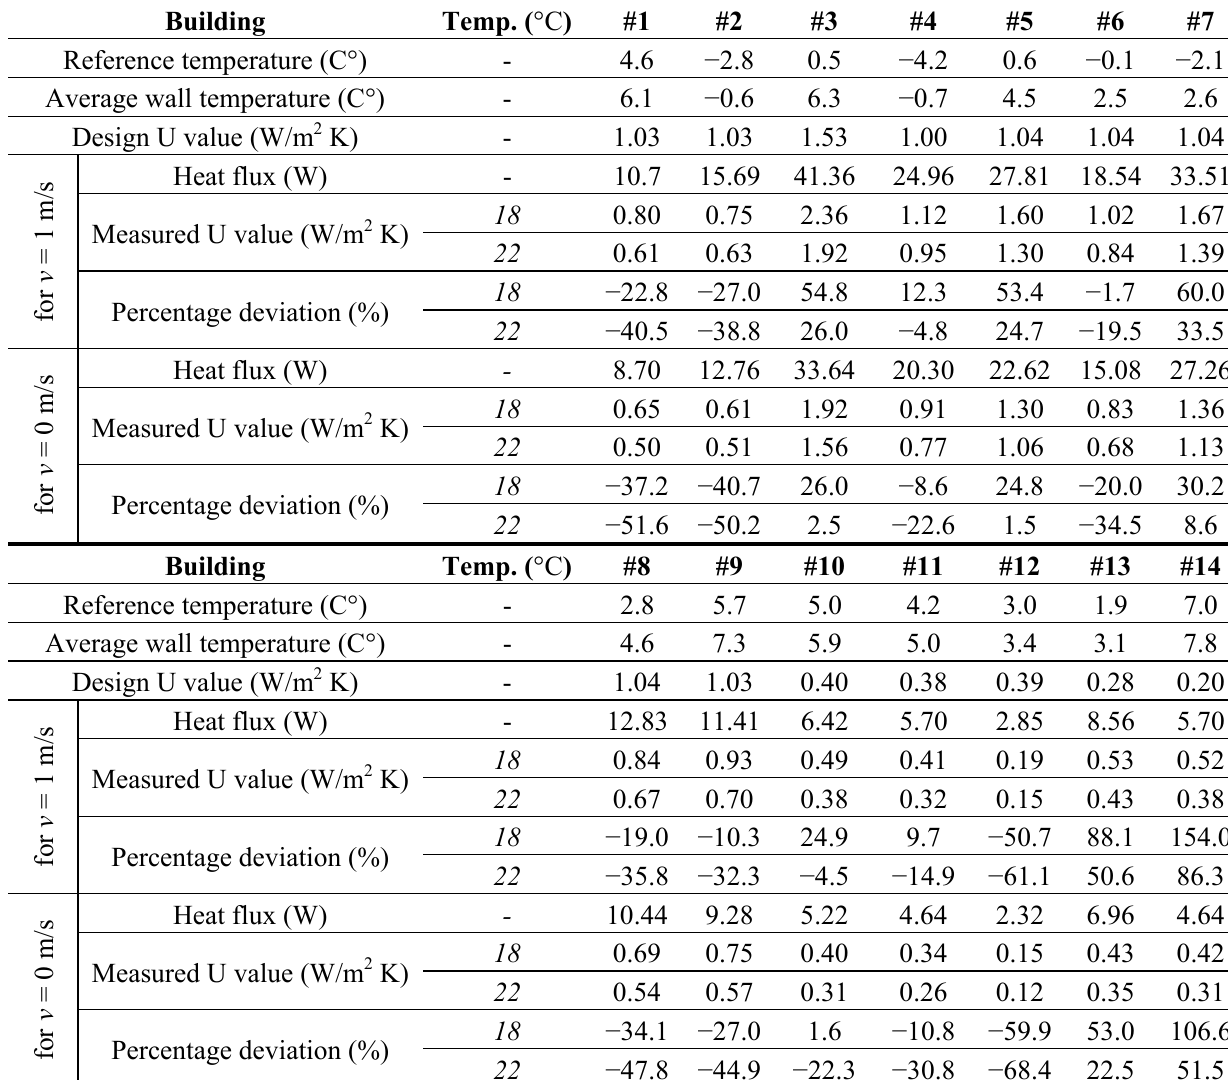
Table 4. Thermal characteristics and percentage absolute deviation between calculated and measured